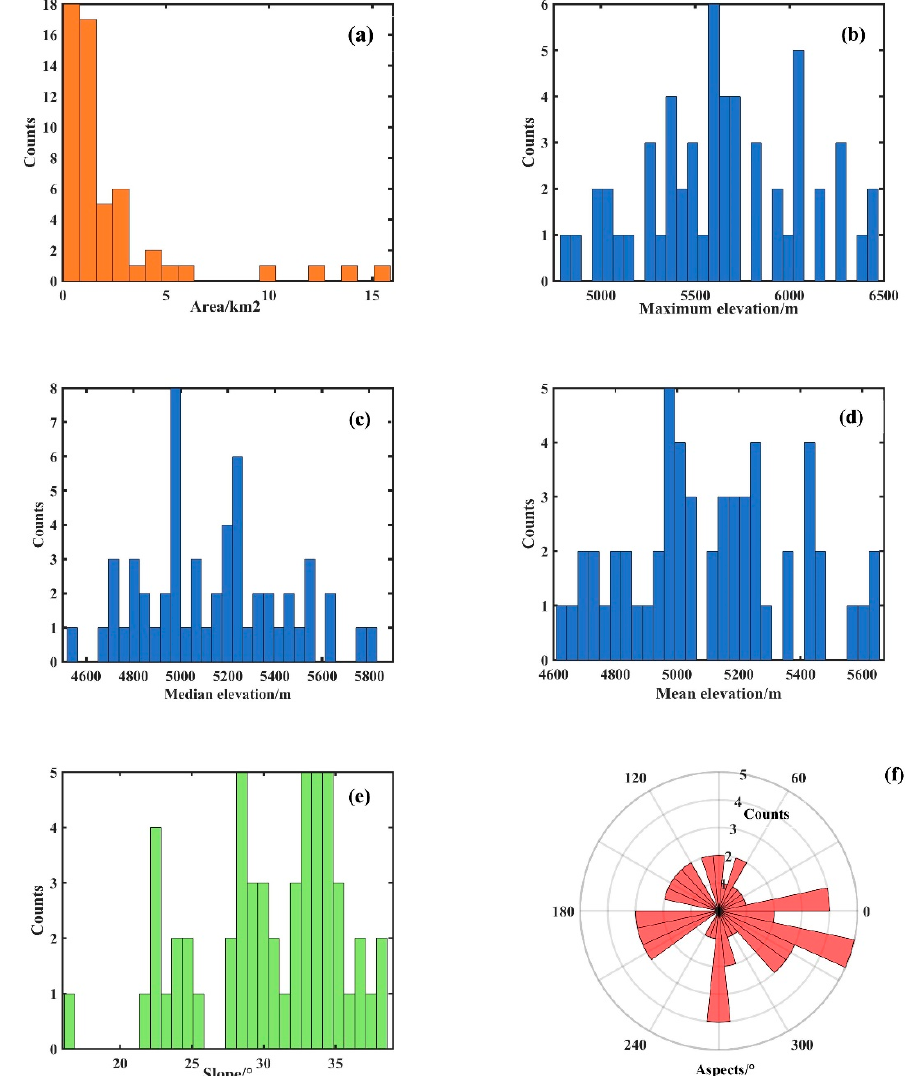
Figure 2. ( a ) Statistical map of mountain glacier area, ( b – d ) statistics of maximum, median and mean elevation of mountain glaciers, ( e ) statistical distribution of mean slope of mountain glaciers, ( f ) statistical distribution of mean aspects of mountain glaciers.